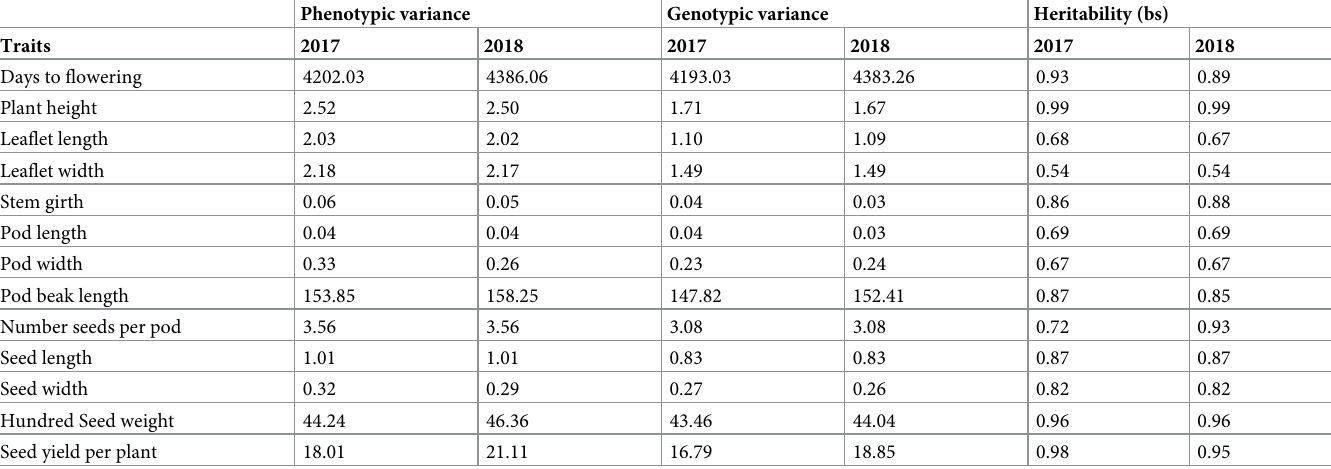
Table 3. Genetic variance components and broad sense heritability for 13 morphological traits of 34 Phaseolus vulgaris